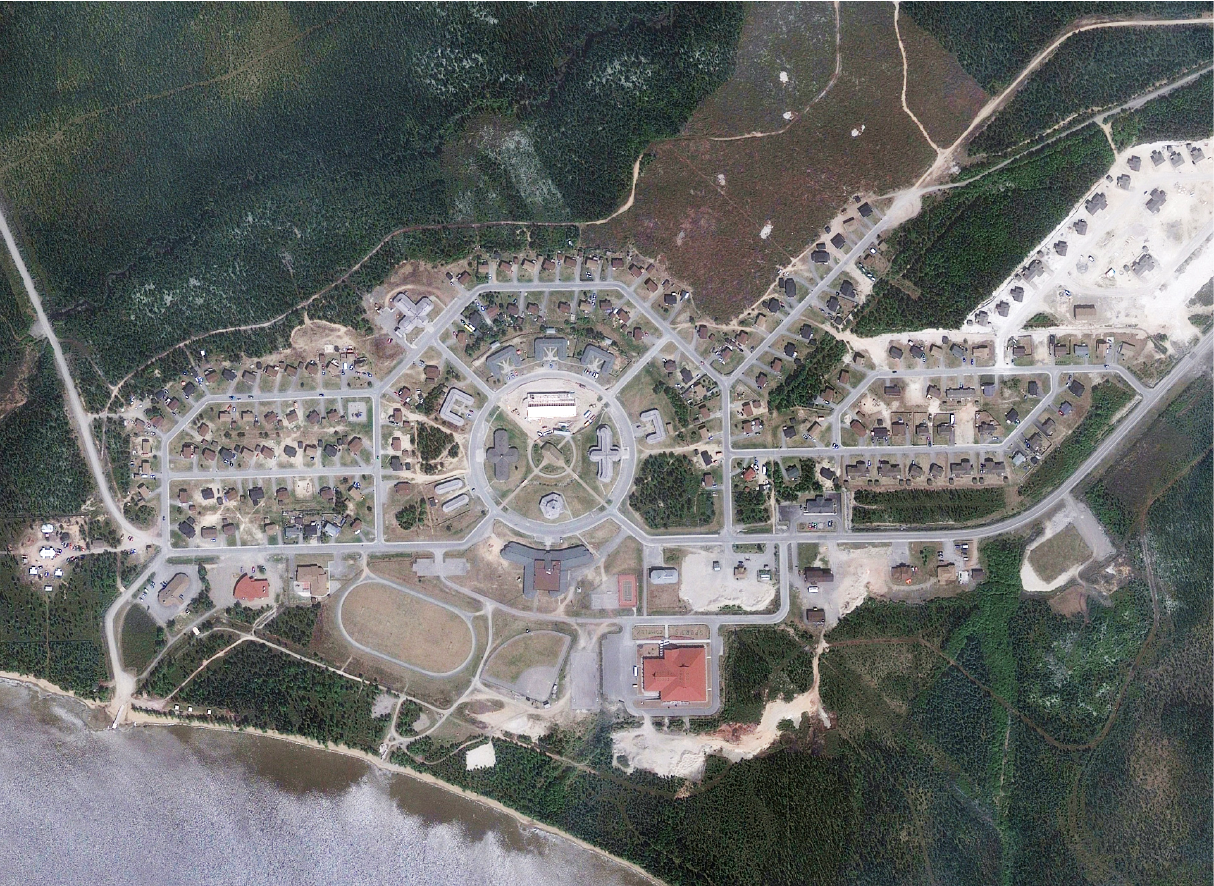
Figure 3. Oujé-Bougoumou, Quebec. Radial grid formed in the development of the new Oujé-Bougoumou community. Source: Author with base from Google